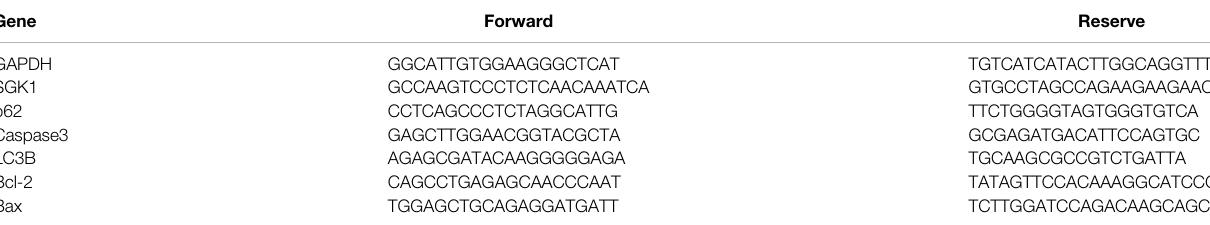
TABLE 1 | Primers in this